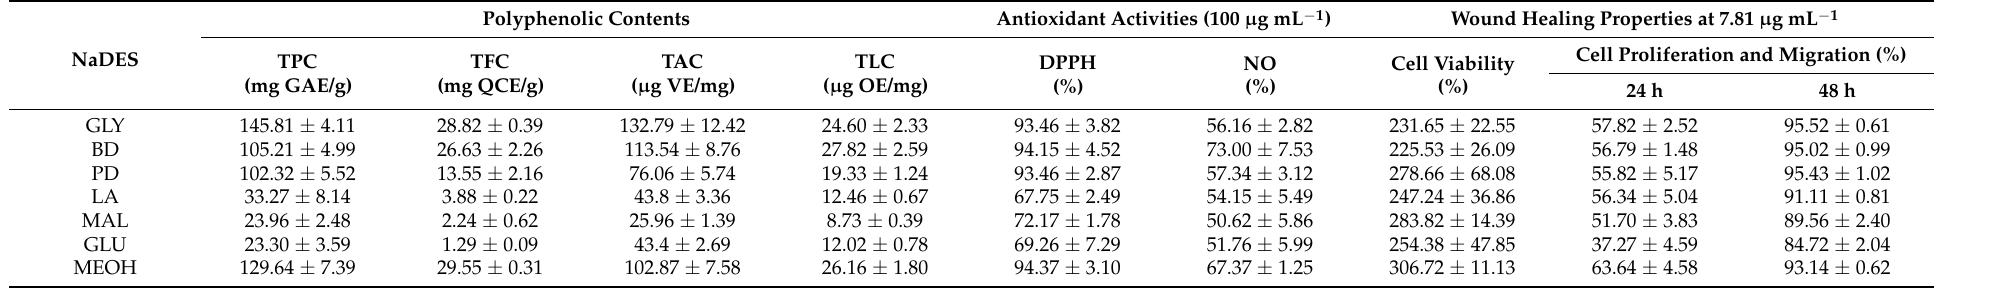
Table 2. Polyphenolic contents, antioxidant activities, and wound healing properties of oil palm leaf-natural deep eutectic solvent extracts.